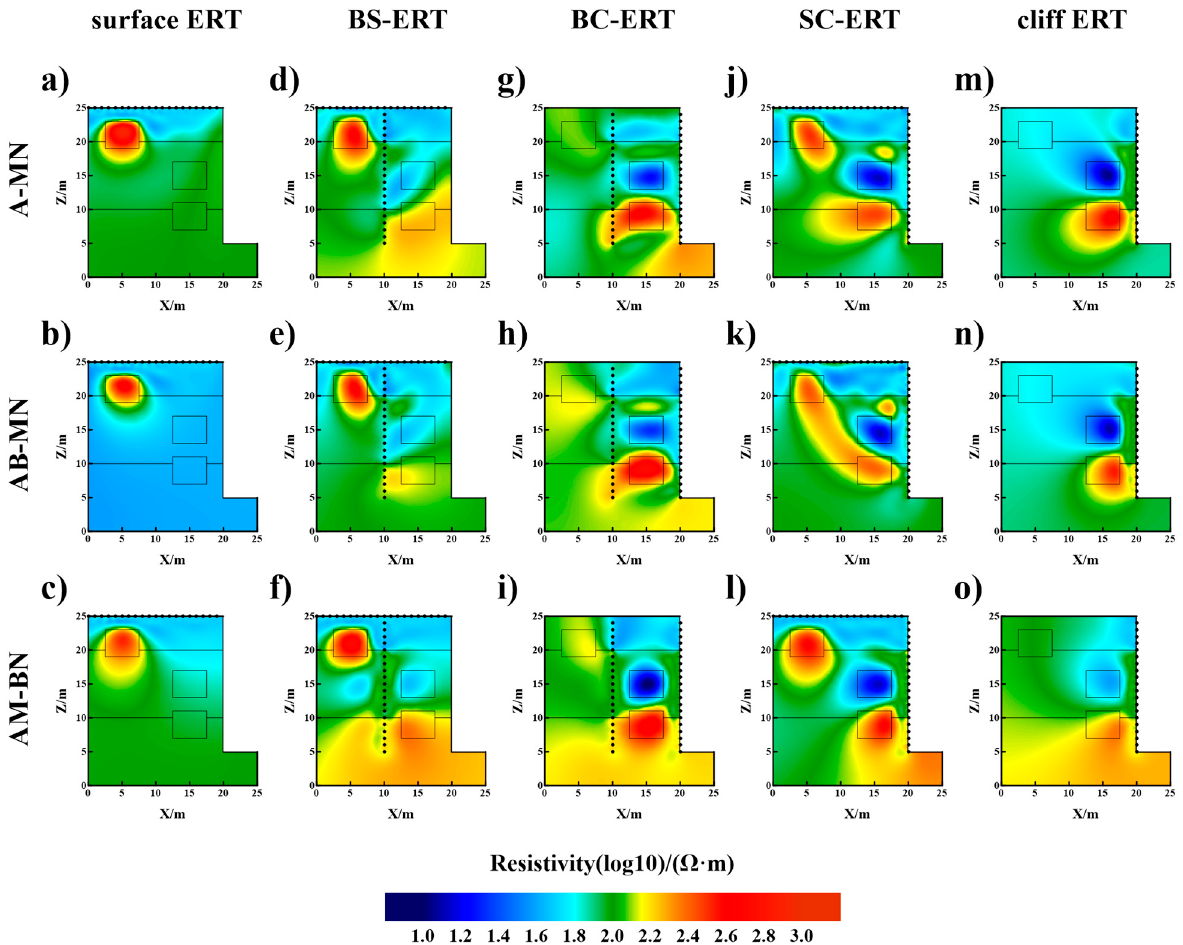
Figure 5. Resistivity imaging of three configurations in five ERT schemes: ( a – c ) surface ERT scheme, ( d – f ) BS-ERT scheme, ( g – i ) BC-ERT scheme, ( j – l ) SC-ERT scheme, ( m – o ) cliff ERT scheme.